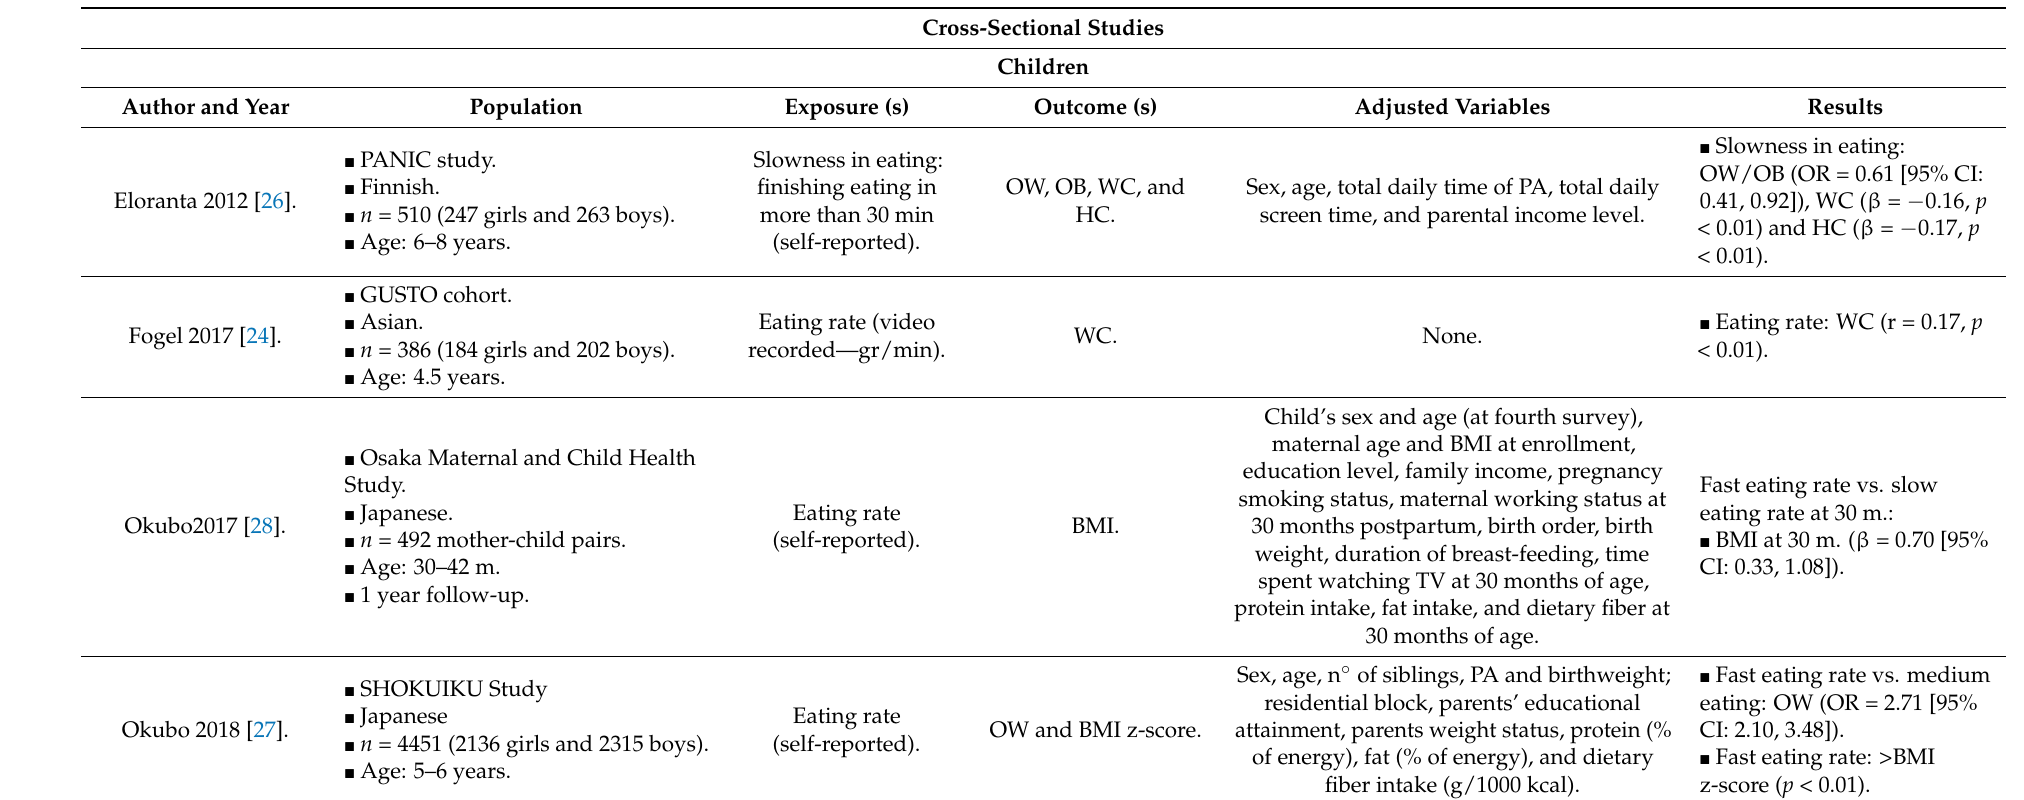
Table 1. Characteristics and main findings of cross-sectional studies that explored eating speed/rate. Cross-Sectional